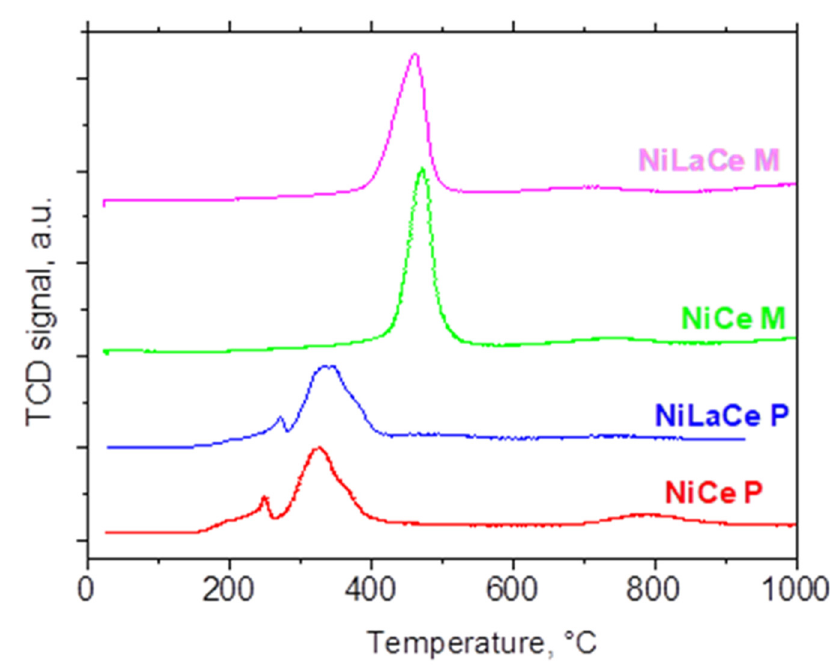
Figure 5. Temperature programmed reduction (TPR) profiles of catalysts.